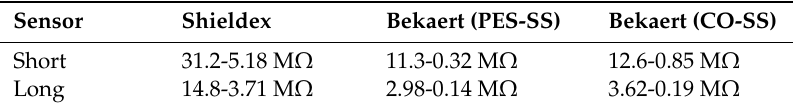
Table 2. Measured sensors module impedances ranges at 2